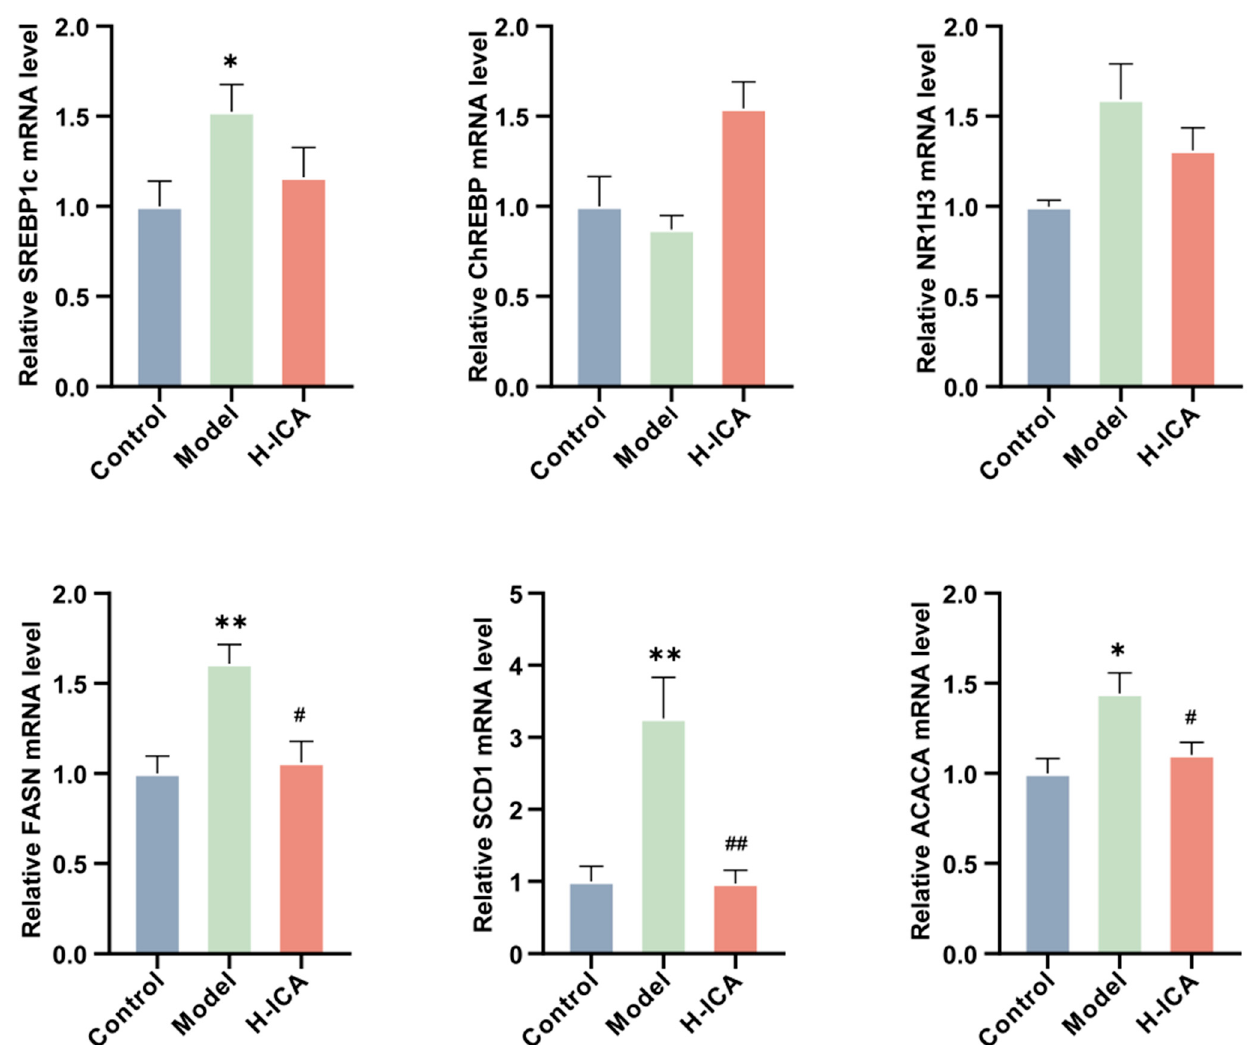
Figure 6. Icariin improves liver steatosis by reducing the expression of genes associated with fatty acid synthesis. Validation of genes involved in fatty acid synthesis in the liver (GAPDH as internal reference). n = 6, values are mean ± SEM; Control vs. Model, * p < 0.05, ** p < 0.01; Model vs. drug group # p < 0.05, ## p < 0.01.